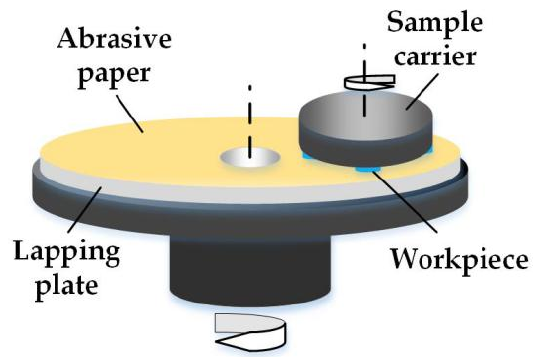
Figure 1. The lapping experimental setup.